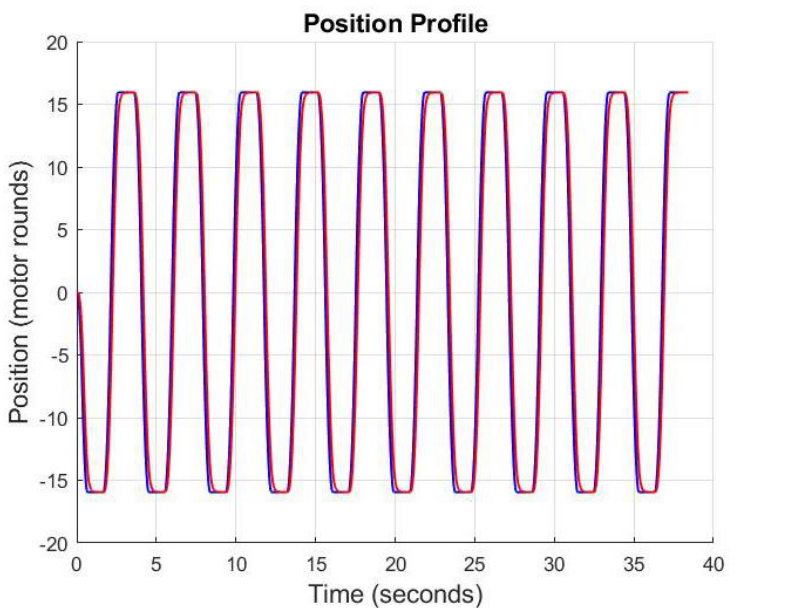
Figure 17. Simulated Real Position Profile (red line); Reference Position Profile (blue line).